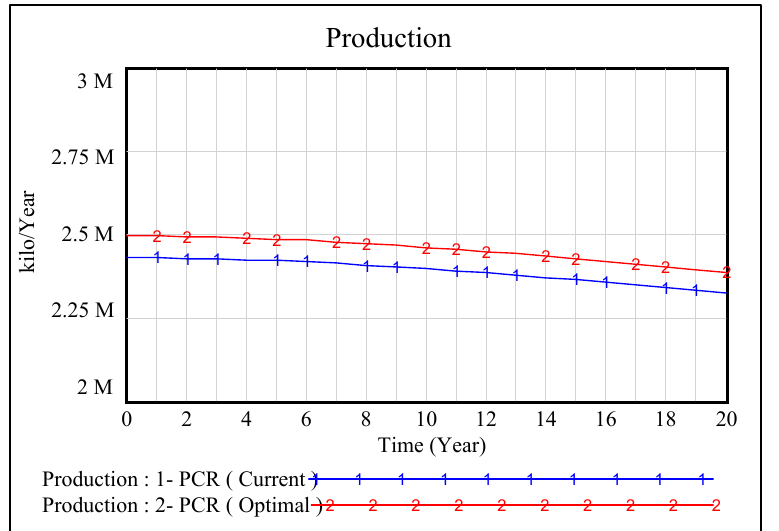
Figure 10. Comparison of the effect of the current and optimal rate of the production cycle on the current variable of the production cycle.